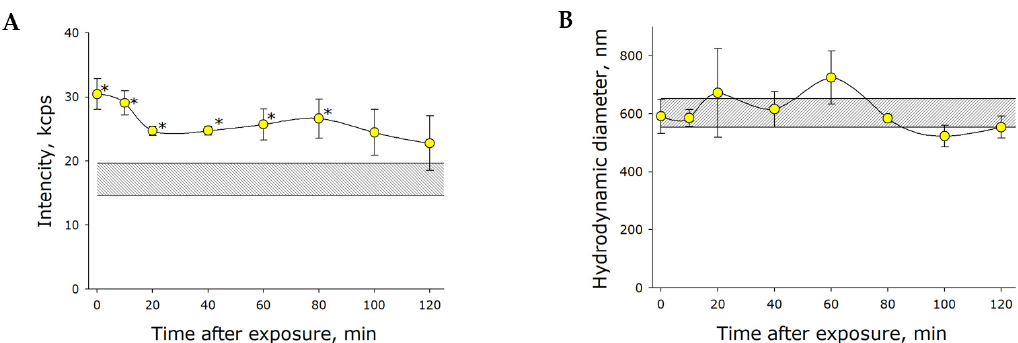
Figure 3. The e ff ect of mechanical stress (30 Hz, 5 mm amplitude) on light scattering intensity ( A ) and hydrodynamic diameter ( B ) of nanosized gas bubbles. The shaded area represents the parameters of the control (gas-saturated water before mechanical treatment). The data are presented as the mean and standard error of the mean for six independent assays. Data di ff er significantly from control values at p < 0.05